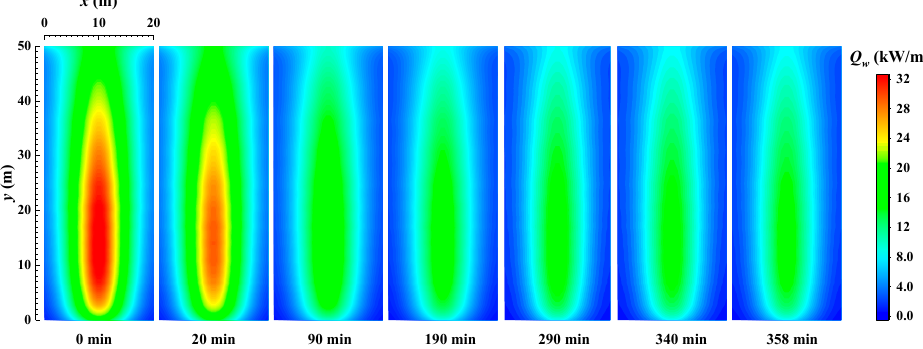
Figure 4. The distribution of the local heat flux density of the wall when burning sub-bituminous coal.